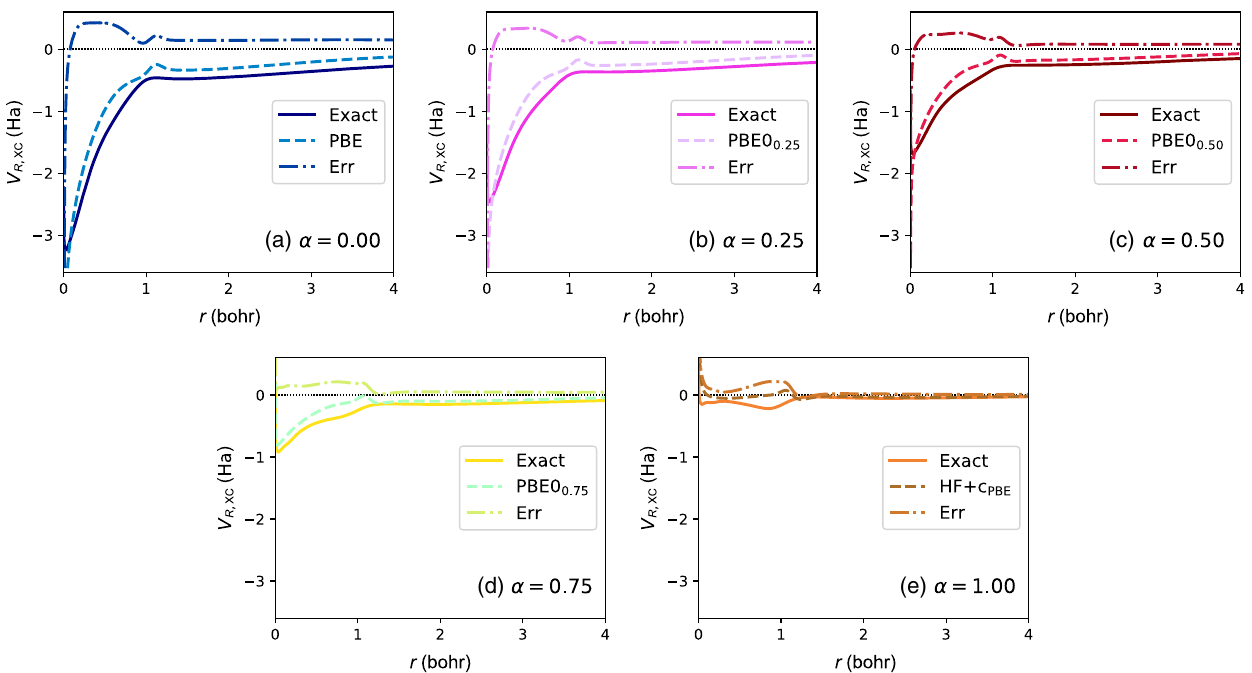
FIG. 4. (a) – (e) Exact (inversion-based) and approximate (PBE 0 α ) remainder exchange-correlation potentials V α R; atom from various choices of the fraction of Fock exchange α . Also shown is the error in the PBE 0 α